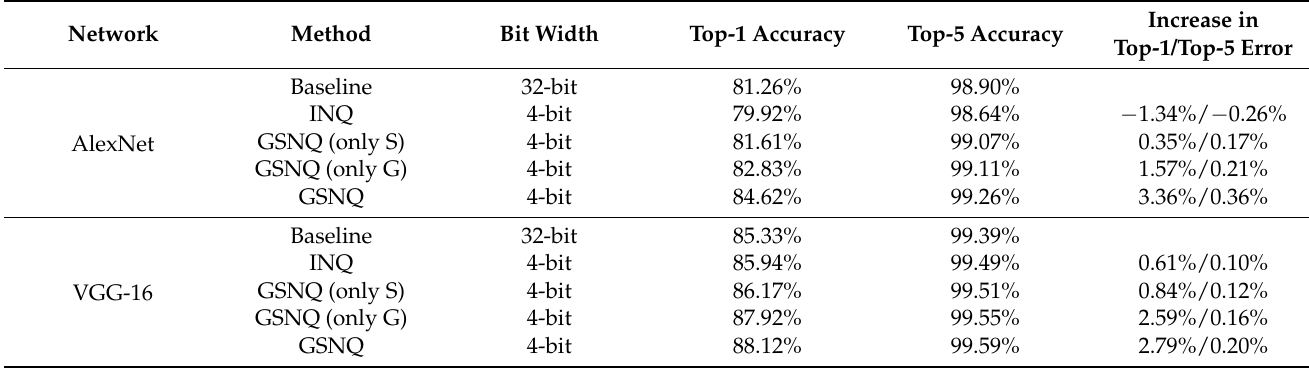
Table 5. Ablation experiments on 4-bit quantization on the CIFAR10